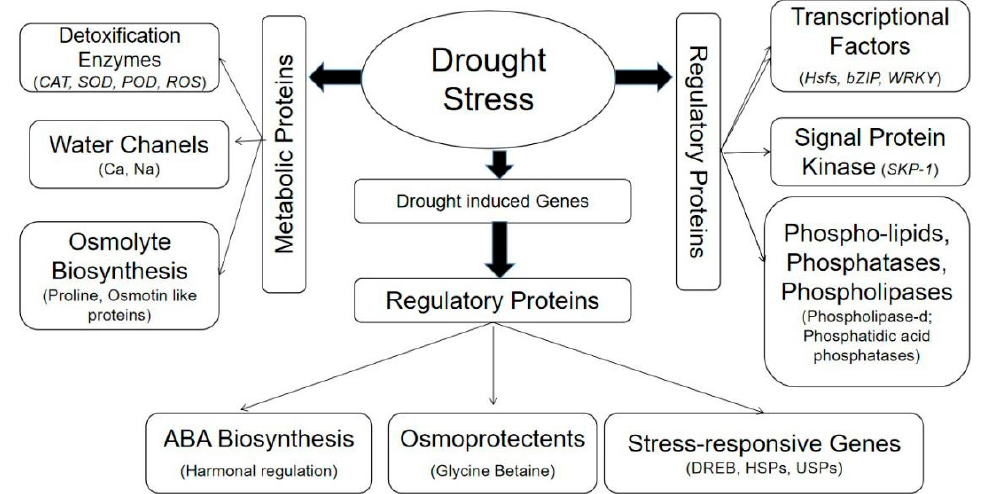
Figure 1. Biochemical and molecular response of plants activated during drought stress.